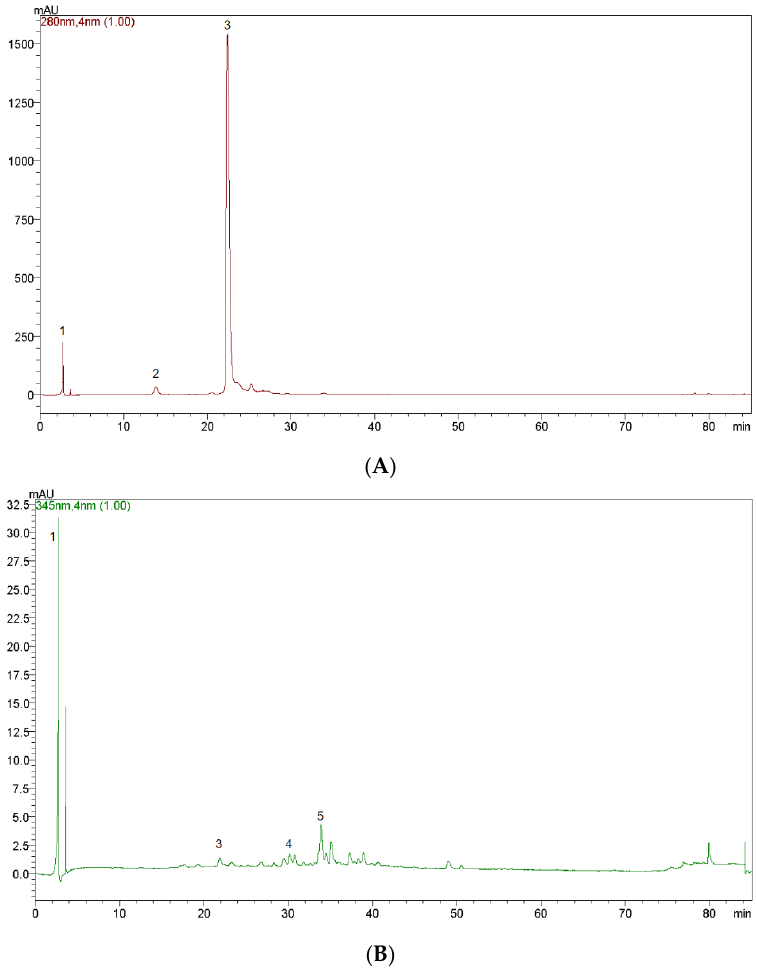
Figure 1. HPLC chromatograms of the sports beverage at 280 nm ( A ) and 345 nm ( B ). The peaks represent the following phenolics: 1 = epicatechin, 2 = protocatechuic acid, 3 = catechin, 4 = luteolin 7-glucoside, and 5 = kaempferol-3-O- β -rutinoside. Note that not all phenolic compounds showed peaks at both wavelengths tested.